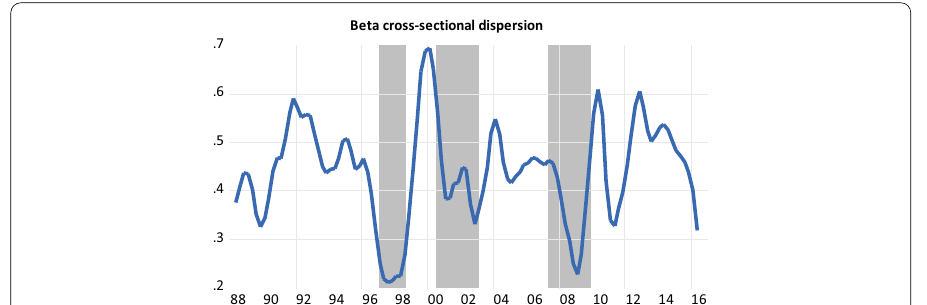
Fig. 7 Beta cross‑sectional dispersion of hedge fund strategies. Notes: For every month, we compute the standard deviation of the conditional strategies’ betas built with the MGARCH procedure. Crisis episodes are